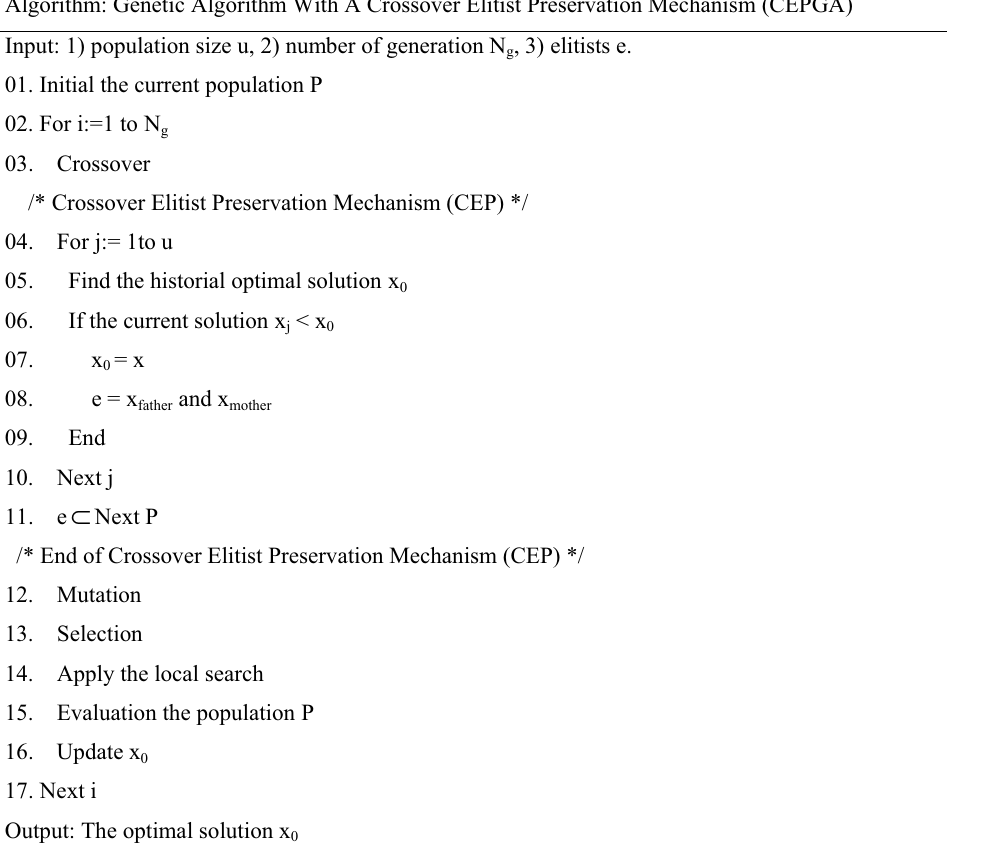
Table 1 Pseudo-code of CEPGA Algorithm: Genetic Algorithm With A Crossover Elitist Preservation Mechanism